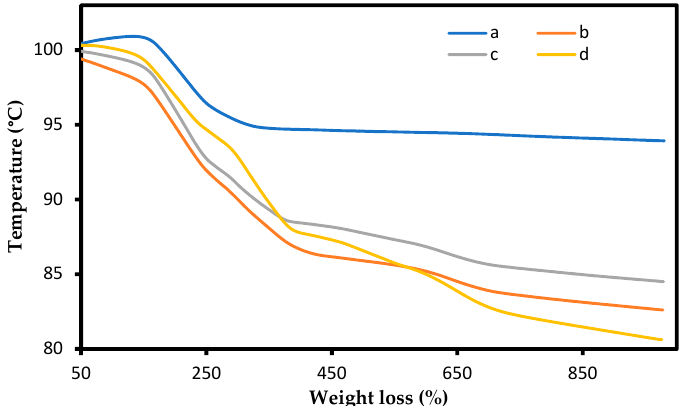
Figure6. TGofthecatalysts: ( a )Pt,Pd,Ni / MgO,( b )Pt,Pd,Ni / Mg 0.97 La 3 + 0.03 O,( c )Pt,Pd,Ni / Mg 0.93 La 3 + 0.07 O, Figure 6. TG of the catalysts: ( a ) Pt,Pd,Ni/MgO, ( b ) Pt,Pd,Ni/Mg 0.97 La 3+0.03 O, ( c ) Pt,Pd,Ni/Mg 0.93 La 3+0.07 O, ( d ) Pt,Pd,Ni/Mg 0.85 La 3+0.15 O. ( d ) Pt,Pd,Ni / Mg 0.85 La 3 + 0.15 O.